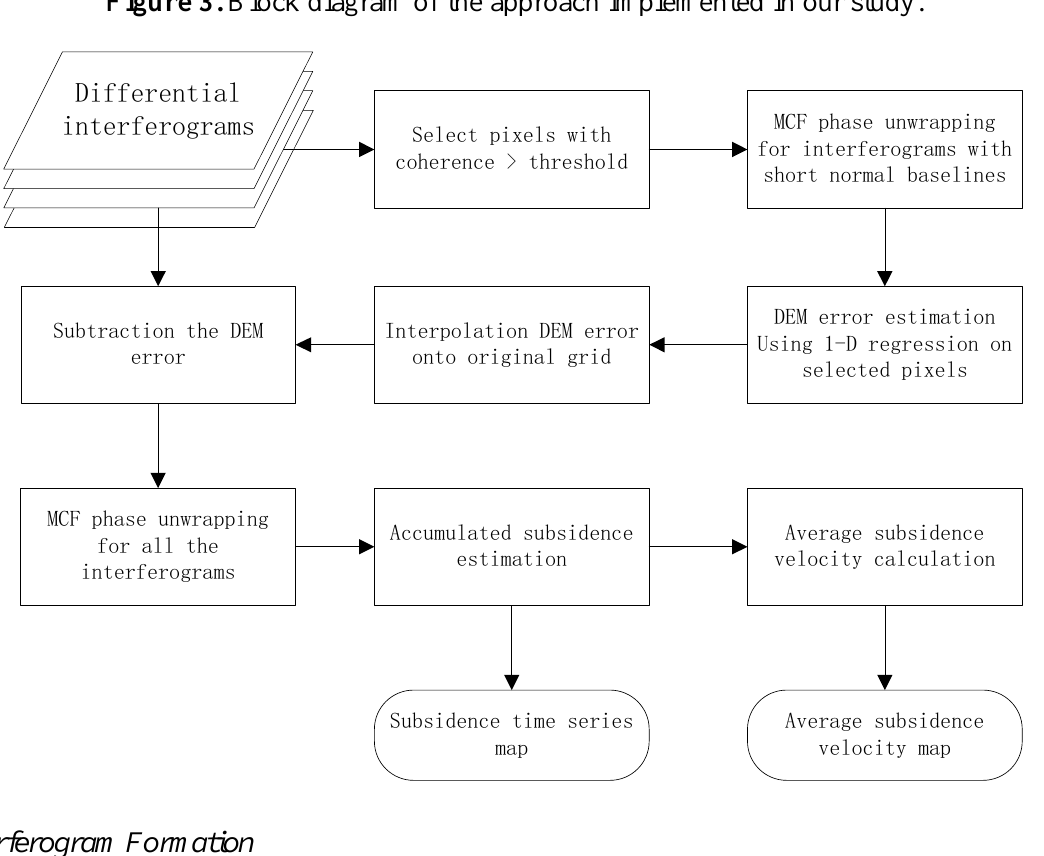
Figure 3. Block diagram of the approach implemented in our